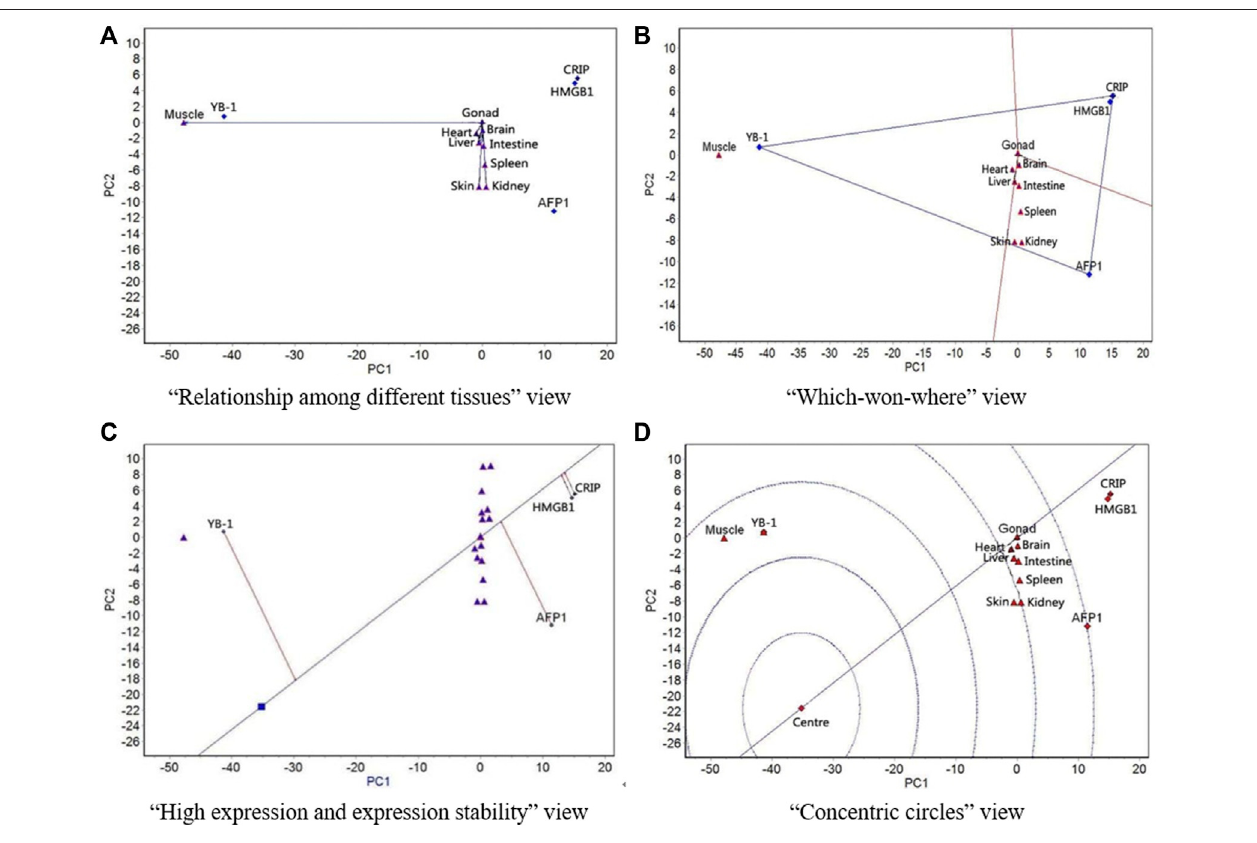
FIGURE 5 | The GGE biplot for expression of four resistance genes to low temperature (AFP1, CIRP, YB-1, and HMGB1) in different tissues at 18 ° C. (A) “ Relationship among different tissues ” view. (B) “ Which-won-where ” view. (C) “ High expression and expression stability ” view. (D) “ Concentric circles ” view.